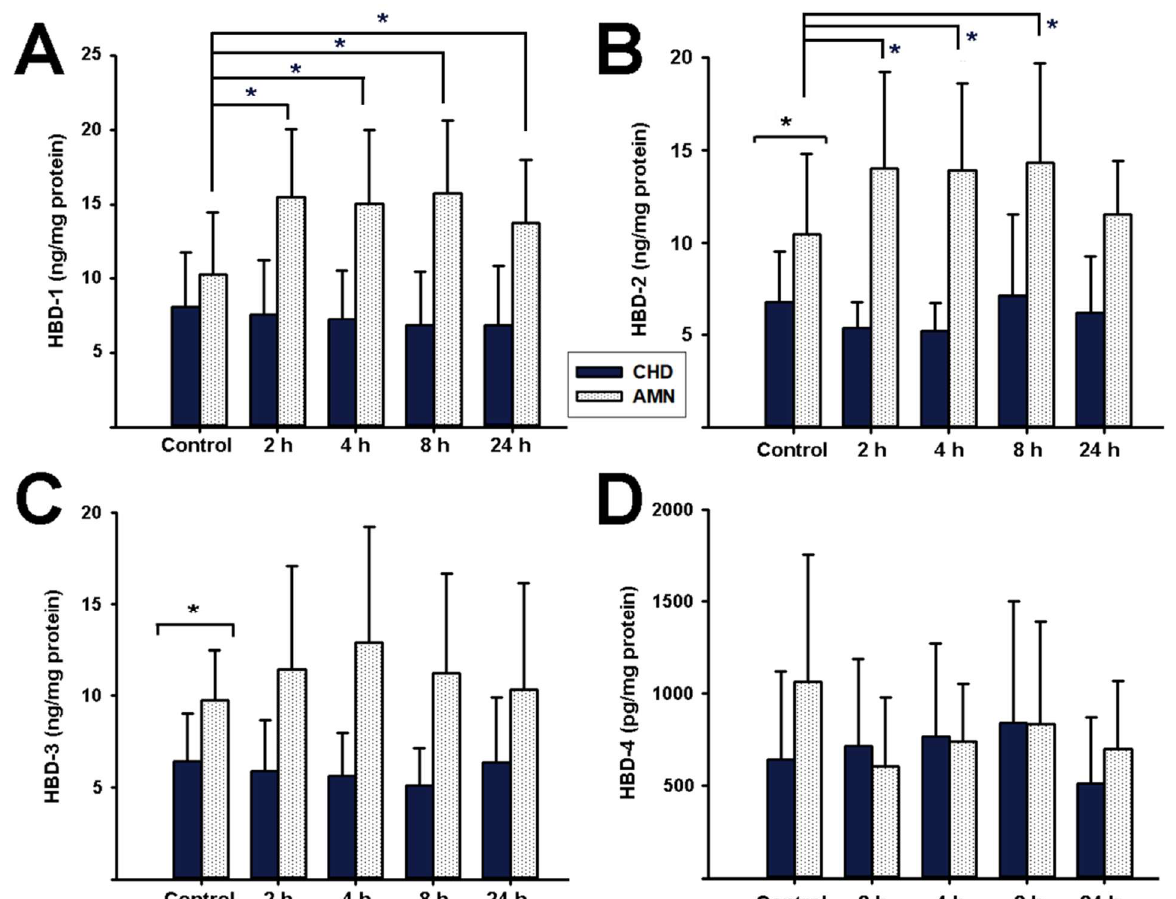
Figure 4. Effect of choriodecidual infection with Escherichia coli upon human beta defensins synthesis. An inoculum of 1 × 10 5 CFU/mL E. coli was used to infect the CHD compartment. The tissue layers were lysed to assess HBD content at each follow-up time point (control, 2, 4, 8, and 24 h). ( A ) HBD-1, ( B ) HBD-2, ( C ) HBD-3, and ( D ) HBD-4. Beta defensin synthesis by the amnion (AMN) is shown in white bars, whereas synthesis by the choriodecidua (CHD) is shown in dark bars. The data are presented as means ± SD. n = 6 independent experiments in duplicate. * p < 0.05.